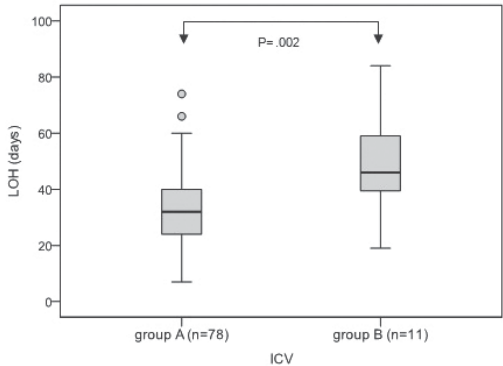
FIGURE 2. Box plot of LOH (days) in both groups